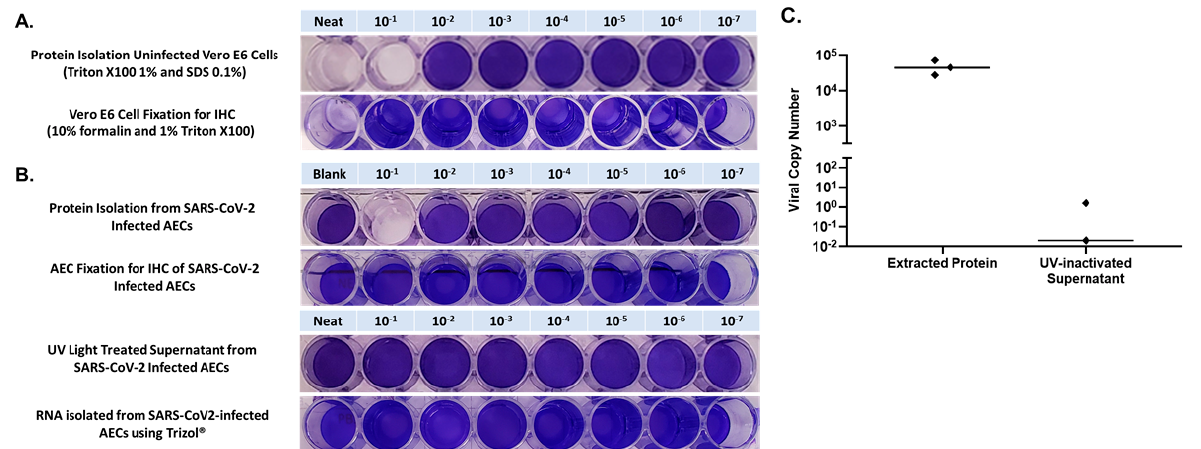
Figure 4. Each experimental condition, and dilution within each condition, were completed in triplicate using 3 separate human primary AEC lines (3 human donors). Results were consistent within each dilution, therefore a single dilution series from one of the 3 primary AEC lines is presented for simplicity. Panel ( A ) presents crystal violet stained uninfected Vero E6 cells exposed to harvested differentiated airway epithelial cell (AEC) cultures treated with Triton X100 1% and sodium dodecyl sulfate (SDS) 0.1% (protein isolation method), or 10% formalin and Triton X100 1% (immunohistochemistry fixation method). AEC material treated with SDS 0.1% resulted in lysis of Vero cells at NEAT and 10 − 1 dilution, and exposure of Vero cells to NEAT material from AECs fixed with 10% formalin and Triton X100 1% also resulted in cell death. Panel ( B ) presents crystal violet stained Vero cells exposed to protein isolated from SARS-CoV-2-infected AECs, material from SARS-CoV-2-infected AECs fixed for immunohistochemistry (IHC), ultraviolet (UV)-light treated supernatant from SARS-CoV-2-infected AECs, and RNA isolated with Trizol ® from SARS-CoV-2-infected AECs. The 10 − 1 dilution of exposure to protein isolated from SARS-CoV-2-infected AECs was not scored as positive given that the same dilution of uninfected AECs treated with SDS 0.1% was toxic to Vero cells. Panel ( C ) presents SARS-CoV-2 viral copy number by quantitative PCR of inactivated material isolated for protein analysis using Radioimmunoprecipitation assay buffer (containing Triton X100 1% and SDS 0.1%) and of UV-inactivated supernatant. Using extracted protein material, RNA was secondarily isolated using Trizol ® before conducting PCR. Similarly, following UV-inactivation, RNA was isolated from the supernatant using Trizol ® before conducting PCR.